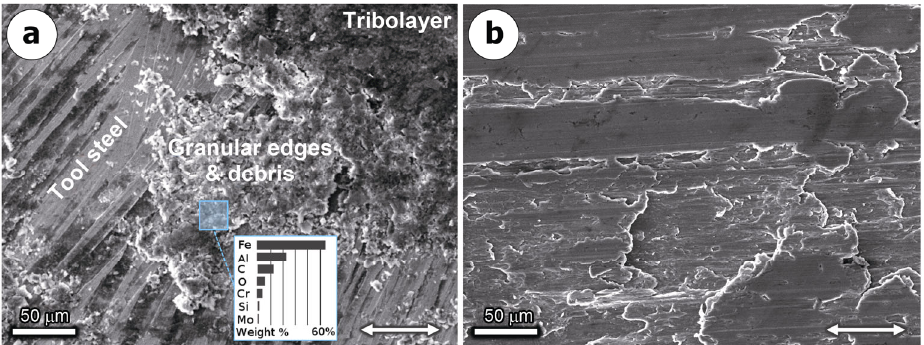
Fig. 10 SEM micrographs of the surface of the (a) as-received tool steel O and (b) aluminium sample surface obtained from the polymer lubricated test at 200× magnification, showing the tribolayer developed on the pin and the wear of the aluminium ( ↔ indicates the sliding direction).